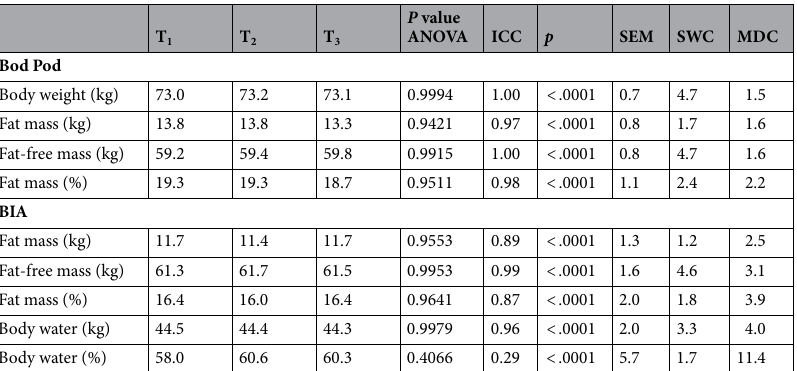
Table 1. Repeatability of body composition measurements. BIA, bioelectrical impedance analysis; ICC, interclass correlation coefficient; MDC, minimal detectable change; SEM, standard error of measurement; SWC, smallest worthwhile change.